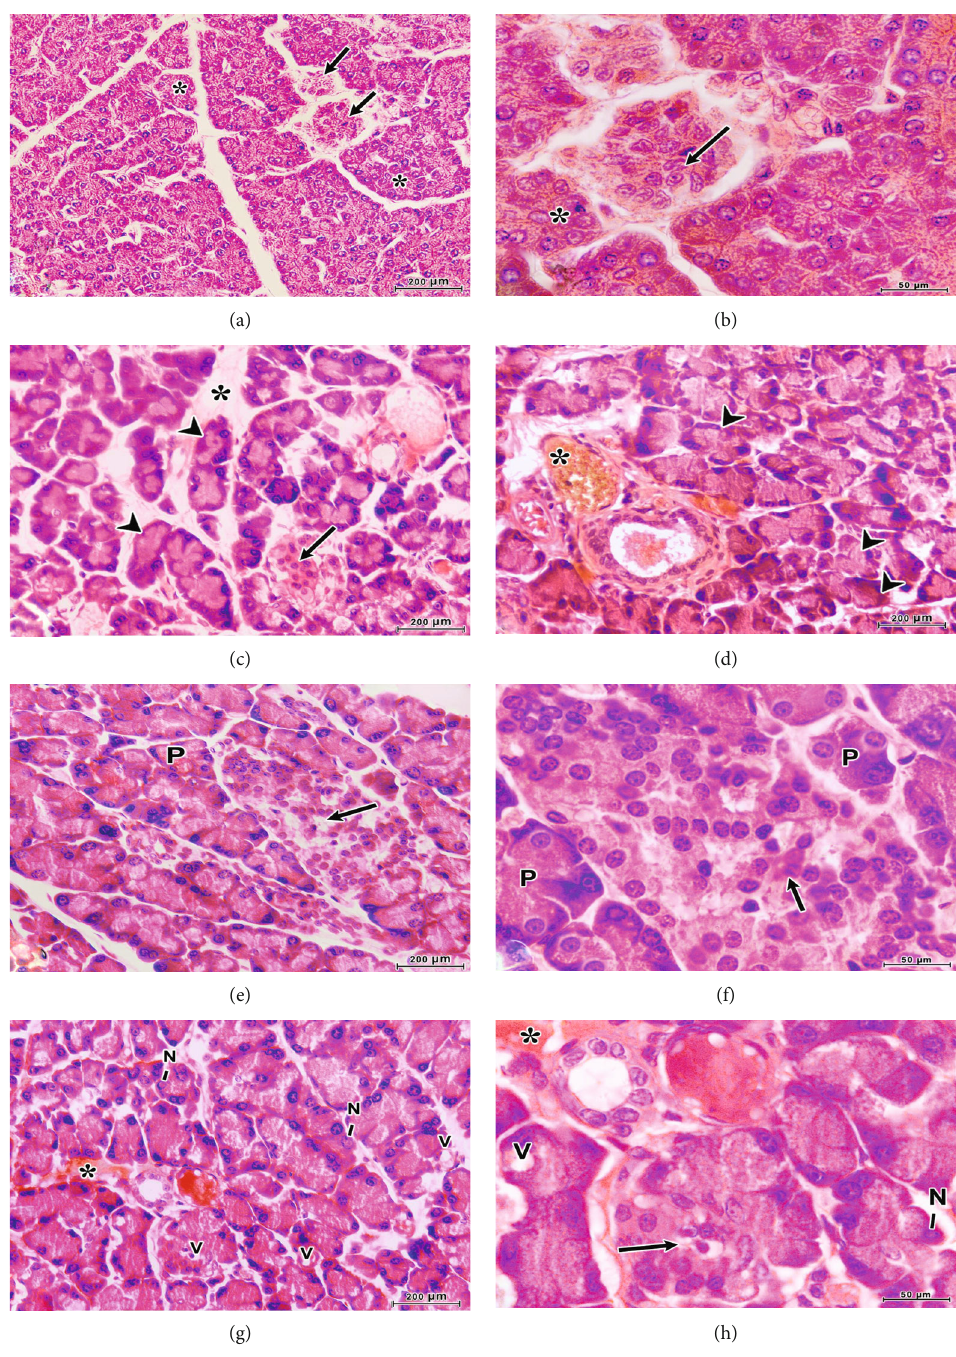
Figure 5: (a, b) Photomicrographs of sections of the pancreas of a control developing rat illustrate closely packed lobules of normal pancreatic acini ( ∗ ) and endocrine islets (arrow). The acini are formed of pyramidal cells with basal nuclei and apical acidophilic cytoplasm. (c, d) Photomicrographs of sections of the pancreas of a diabetic developing rat show severe reduction and shrinkage of islets of Langerhans (arrow) with degeneration and necrosis of the acini components (arrowheads) and extravasations of blood from the damaged blood capillaries forming hemorrhagic appearance ( ∗ ). (e, f) Photomicrographs of sections of the pancreas of a diabetic developing rat treated with mesenchymal stem cells during early phase (diabetic+MSCs1 group) show normal pancreatic acini (P) and some acinar cells with cytoplasmic degeneration. Note the increase in density (arrow) and size of islet in this group. (g, h) Photomicrographs of sections of the pancreas of a diabetic developing rats, treated with mesenchymal stem cells during late phase (diabetic+MSCs2 group), show no signi fi cant recovery. The focal acinar damage represented by cytoplasmic vacuolation (V) and the nuclei (N) exhibited karyolysis of some acinar cells with shrinkage of islets of Langerhans